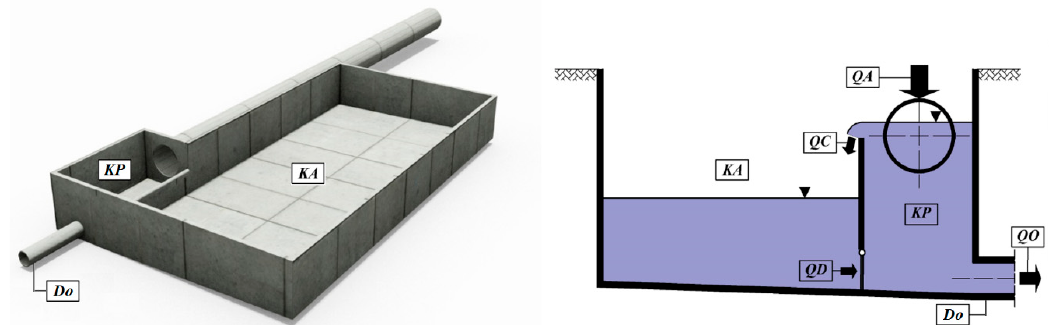
Figure 4. Hydraulic system of the multi-chamber detention tank.